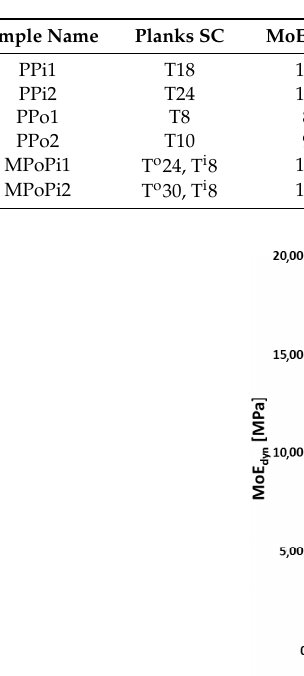
Figure 10. Numerical and experimental load-displacement plots and their corresponding yield limits. Table 1. Main mechanical properties of the tested samples. MoE st : static modulus of elasticity. MoE FEM,G : numerical modulus of elasticity using G. MoE dyn,gt : dynamic modulus of elasticity. MoE c : semi-anaytical modulus of elasticity. σ max : Maximum stress. PPi: Single-species pine. PPo: Single-species poplar. MPoPi: mixed poplar / pine. T o : Outer planks. T i : Inner planks.